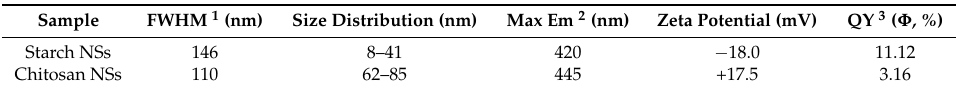
Table 1. Physicochemical parameters of the polysaccharide-based novel nanostructures (NSs) prepared from starch and chitosan.